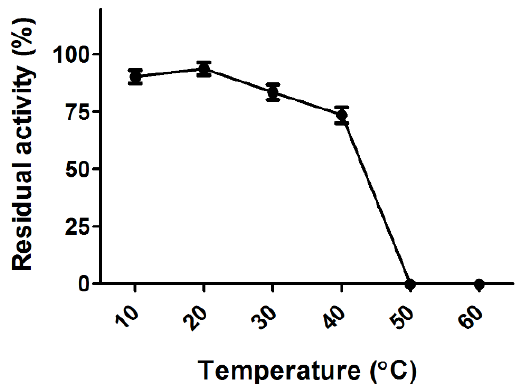
Figure 5. Thermal stability of the proteolytic activity of SK1-1. The crude protease was pre-incubated at temperatures ranging from 10 °C to 60 °C for 1 h prior to the enzymatic reaction. Residual proteolytic activity was assessed in comparison to that of the control (no pre-incubation).